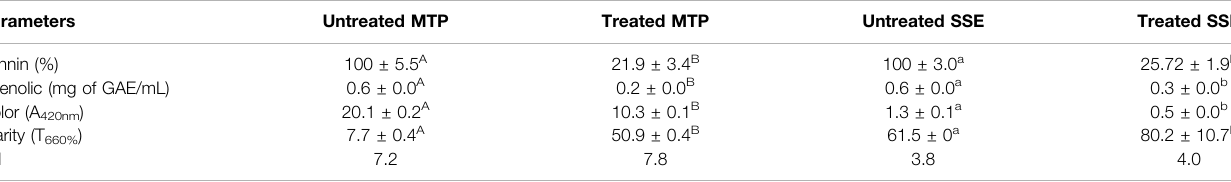
TABLE 4 | Physical – chemical characteristics of MTP and SSE ef fl uents before and after treatment using Ca-alginate derivative containing A. fumigatus CAS21 tannase in the PBR.